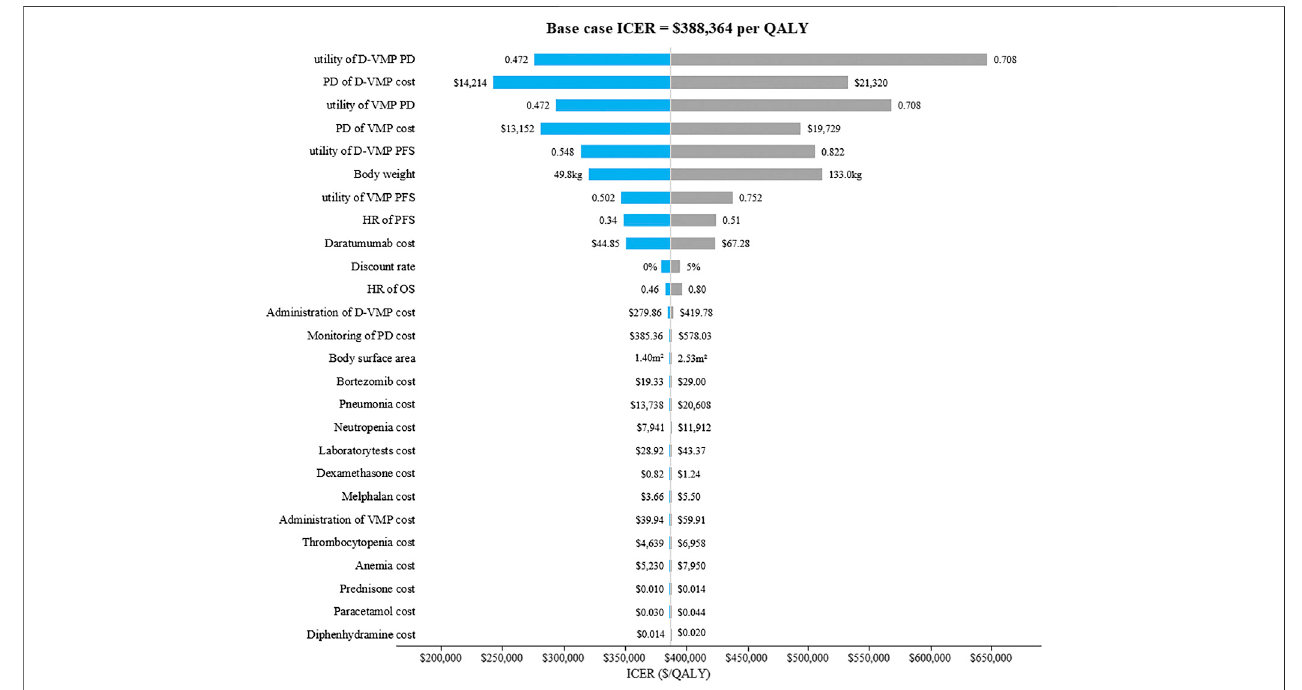
FIGURE 2 | The tornado diagrams of one-way sensitivity analysis. D-VMP: daratumumab plus bortezomib, melphalan and prednisone; VMP: bortezomib, melphalan and prednisone; PD: progression disease; HR: hazard ratio; PFS: progression-free survival; OS: overall survival. ICER: incremental cost-effectiveness ratio; QALY: quality-adjusted